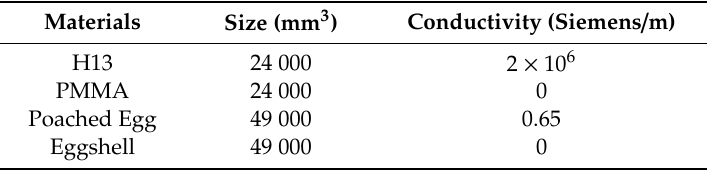
Table 1. The parameters of the experimental materials.